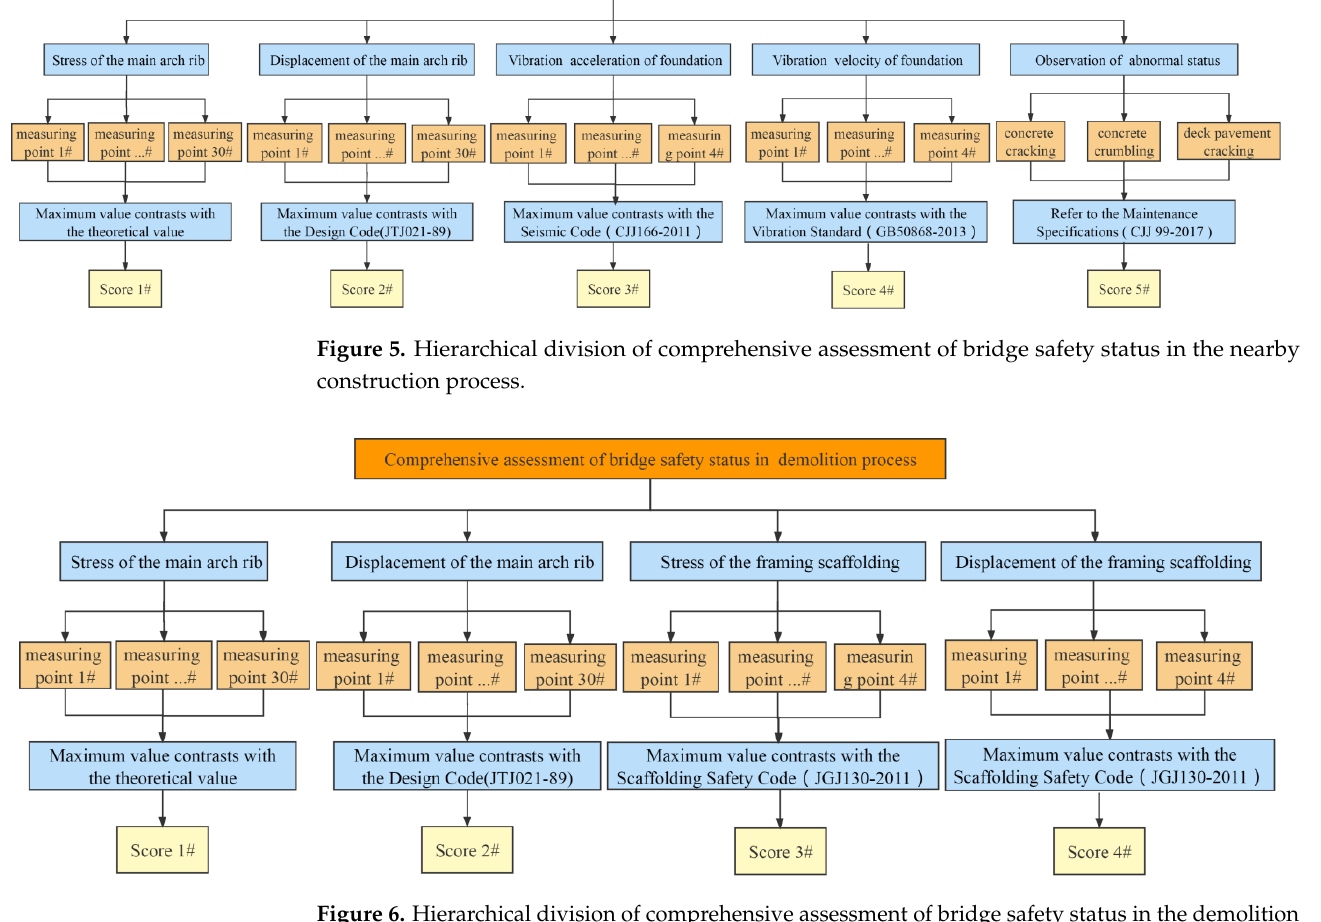
Figure 5. Hierarchical division of comprehensive assessment of bridge safety status in the nearby construction process.